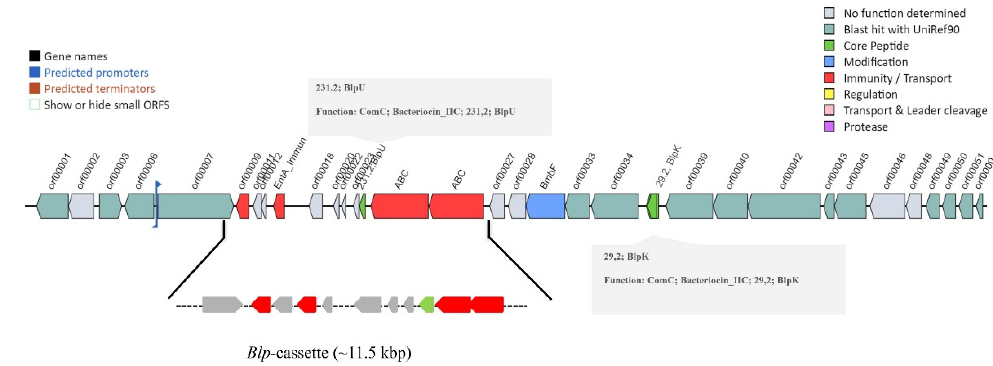
Figure 2. Genetic arrangement of the blp locus in S. salivarius 24SMBc produced with the BAGEL4 tool. Interestingly, the presence of the other blpK bacteriocin is to the right of the blp cassette carrying blpU